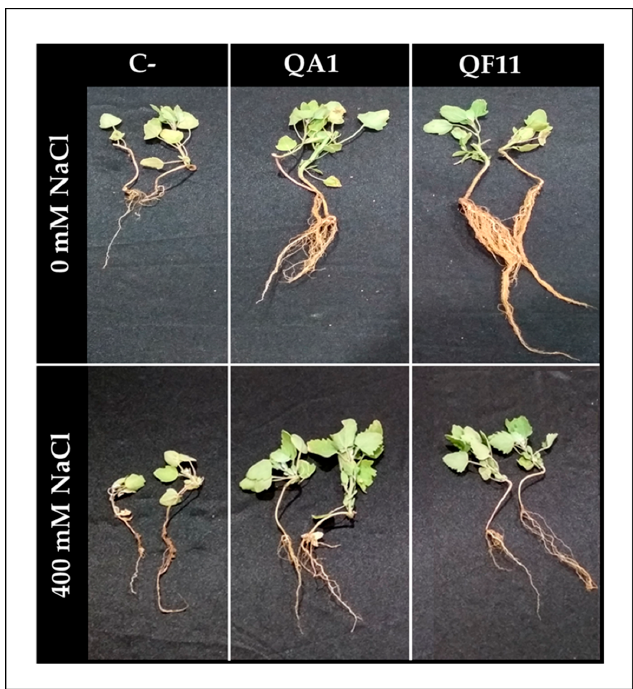
Figure 6. Effect of tested PSB on quinoa plant growth after 45 days of culture under normal (0 mM NaCl, tap water) and saline (400 mM NaCl) irrigations.